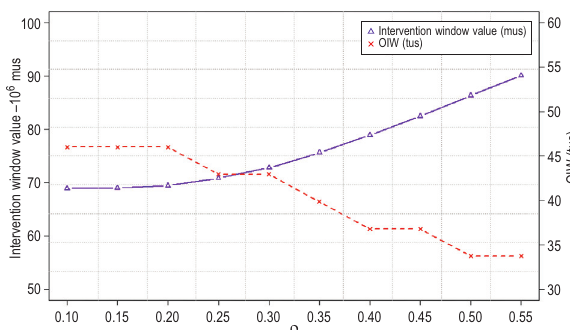
Fig. 5. Values of optimal intervention windows for different standard deviations of the price of transporting